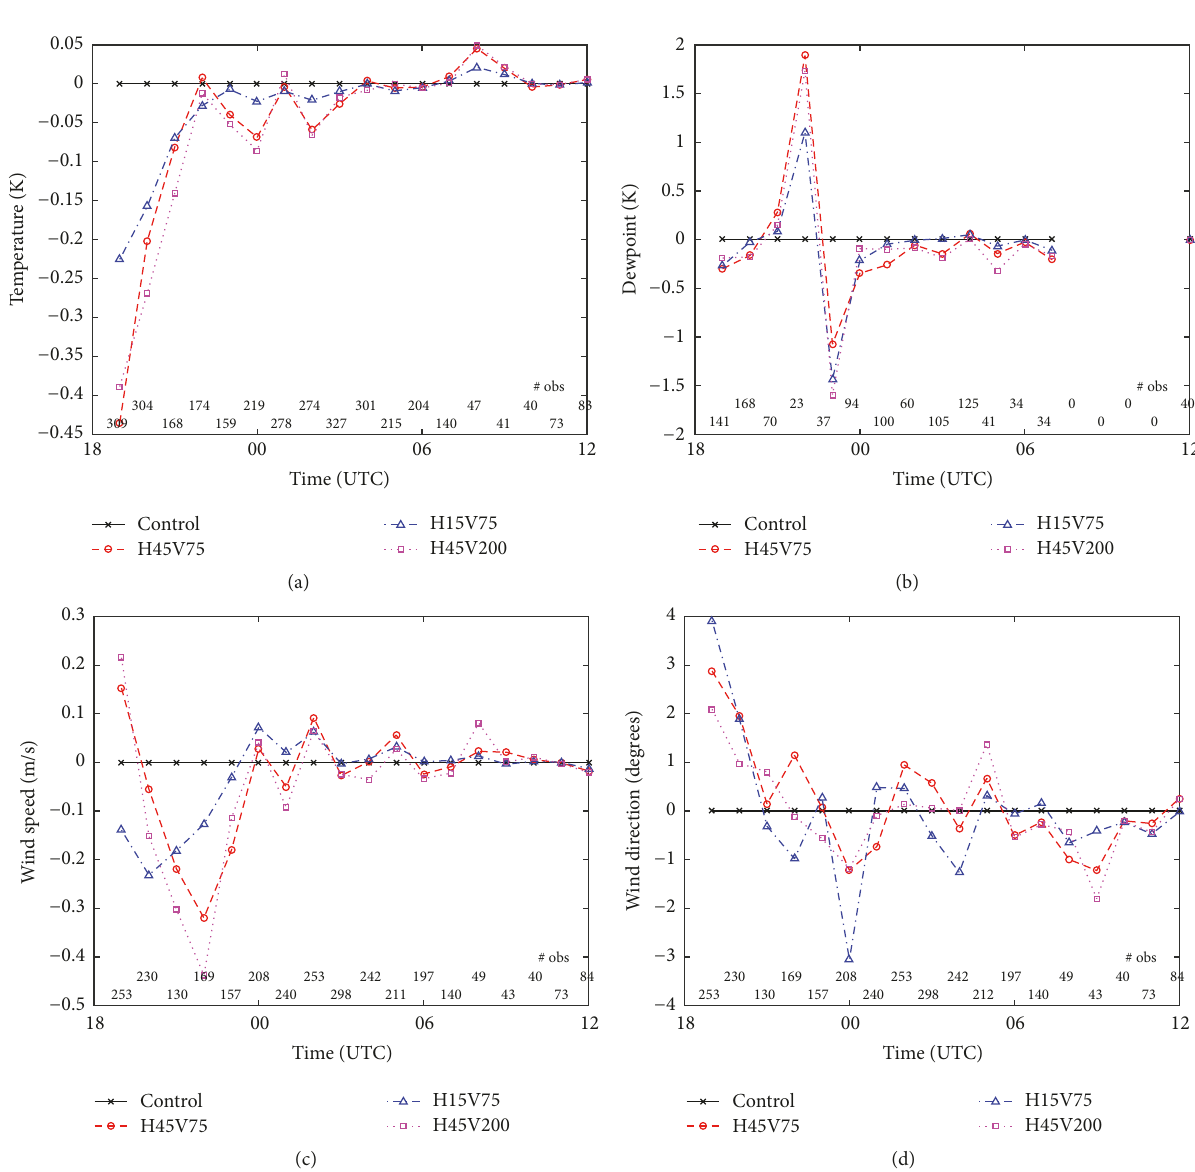
Figure6:TimeseriesofthedifferencebetweenMAEforeachexperimentcomparedtotheMAEforExp.Controlforthe1–18 hforecast(19–12 UTC) for the 0–1000 m AGL layer for (a) temperature, (b) dewpoint, (c) wind speed, and (d) wind direction as compared to above-surface observations and calculated over observations from all five case days. Values below the horizontal line indicate an experiment performed better than Exp. Control. The number of observations used to create the verification at each time is noted just above the horizontal axis at the bottom of the